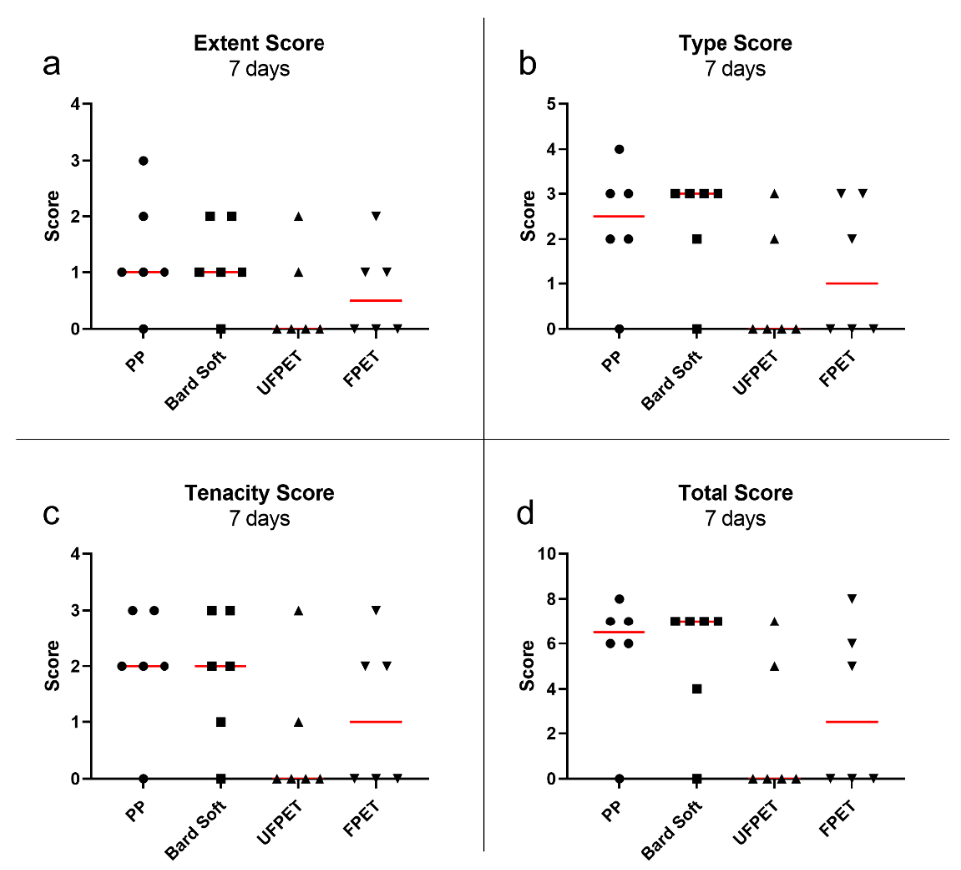
Figure 7. Scatter plot of Diamond adhesion scores after 7 days. Red bar denotes median. Kruskal– Wallis comparisons did not reach the significance threshold of p < 0.05. ( a ) Extent score, ( b ) Type score, ( c ) Tenacity score, ( d ) Total score.